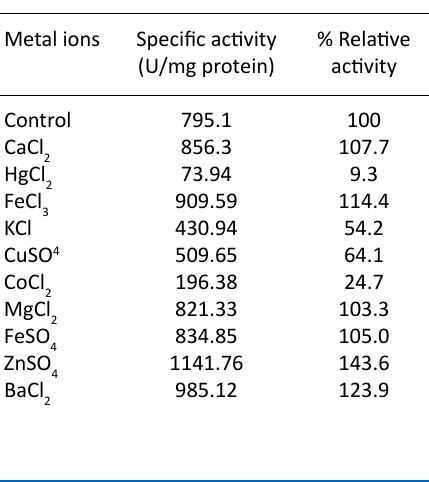
Table 3. Effect of adifferent inhibitor of LKE-021 Table 2. Metal ions effect on the enzyme activity